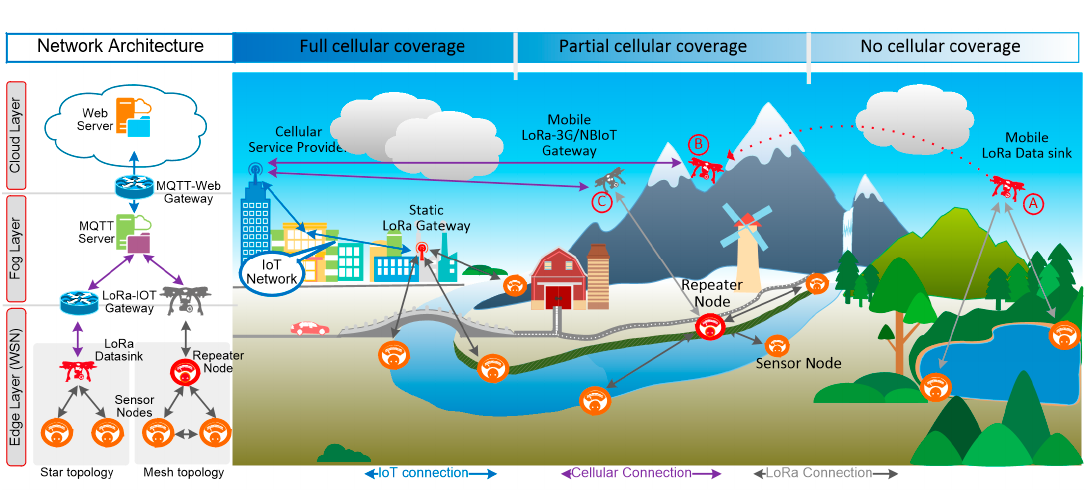
Figure 2. A Wide-Area Remote Monitoring (WARM) application focusing the WQM with dynamic network configuration.